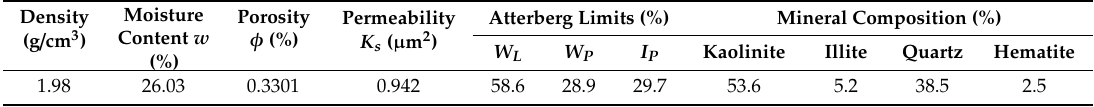
Table 1. Basic parameters of the tested residual